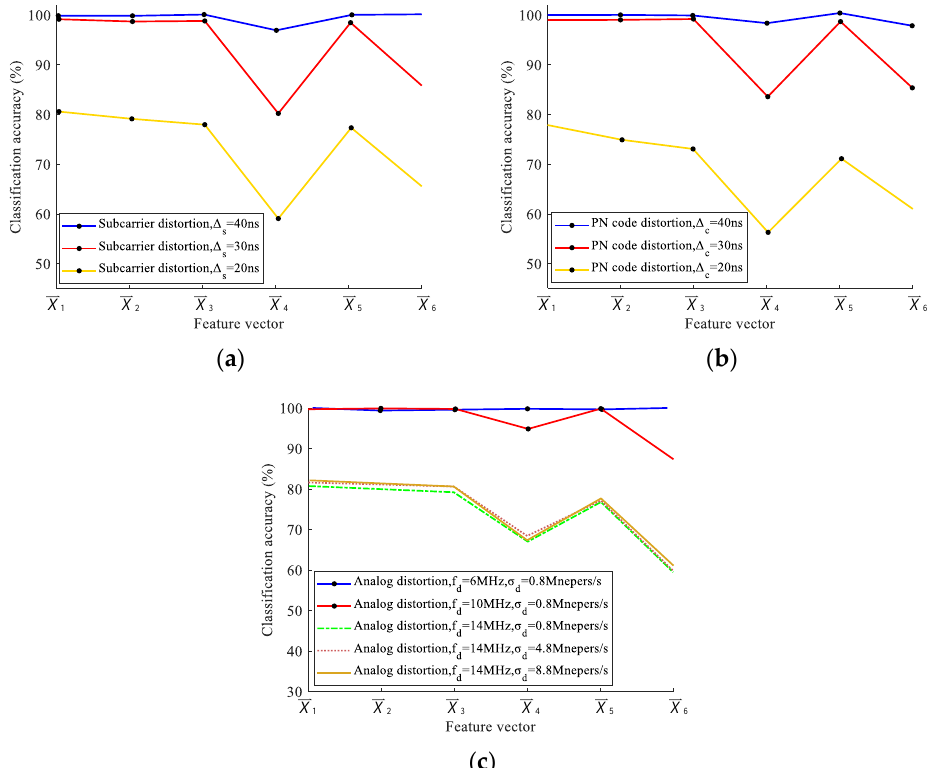
Figure 9. Classification accuracy of different feature vectors. ( a ) Subcarrier distortions; ( b ) PN code distortions; ( c ) Analog distortions.